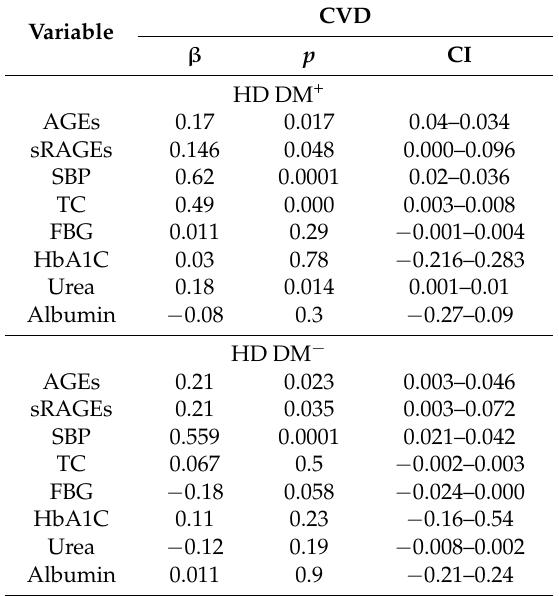
Table 6. Linear regression analysis to investigate independent factors associated with CVD in